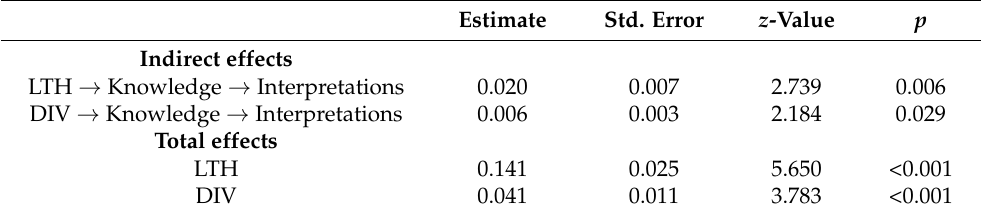
Table 3. Mediation